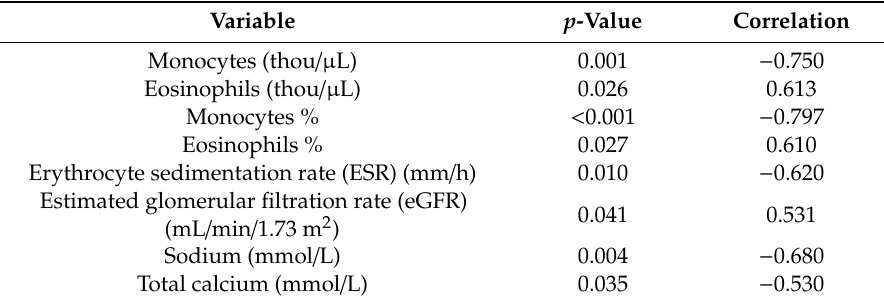
Table 4. The p -values and correlations for the VO2 max of the athletes.